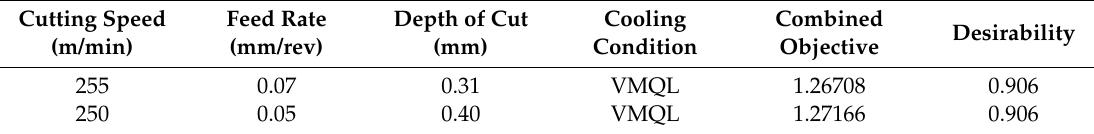
Table 4. Optimized results (desirability approach).